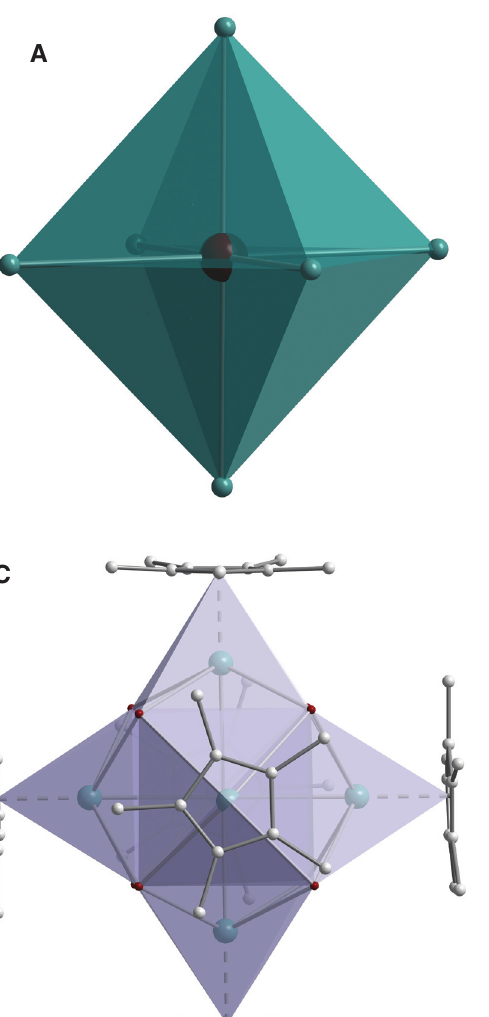
Figure 3 View of structural arrangements of the anion and the cation of [Bi (A) Bi octahedron containing an interstitial Br atom inside the {Bi coordinated Br - ligands; (C) a Bi octahedron containing an interstitial Br atom and six η 5 -coordinated Cp* ligands; (D) seven distorted edge- sharing BiBr -octahedra connected by μ 6